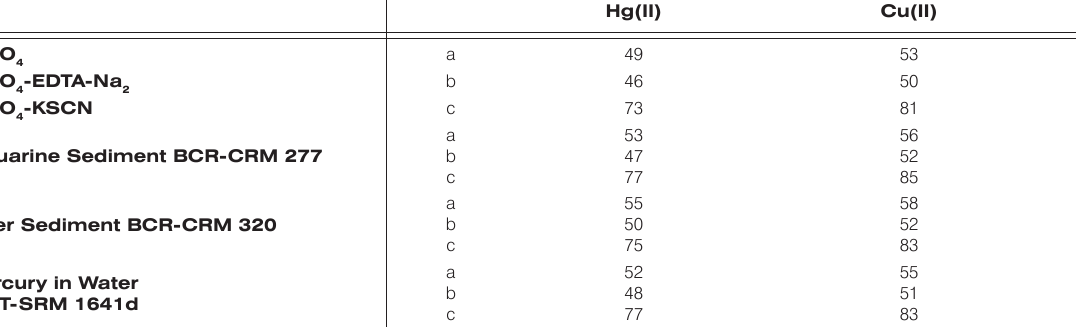
Table 3. Half peak width w (mV) for the aqueous reference solutions and for the solution obtained by digestion of the standard reference 1/2 materials.